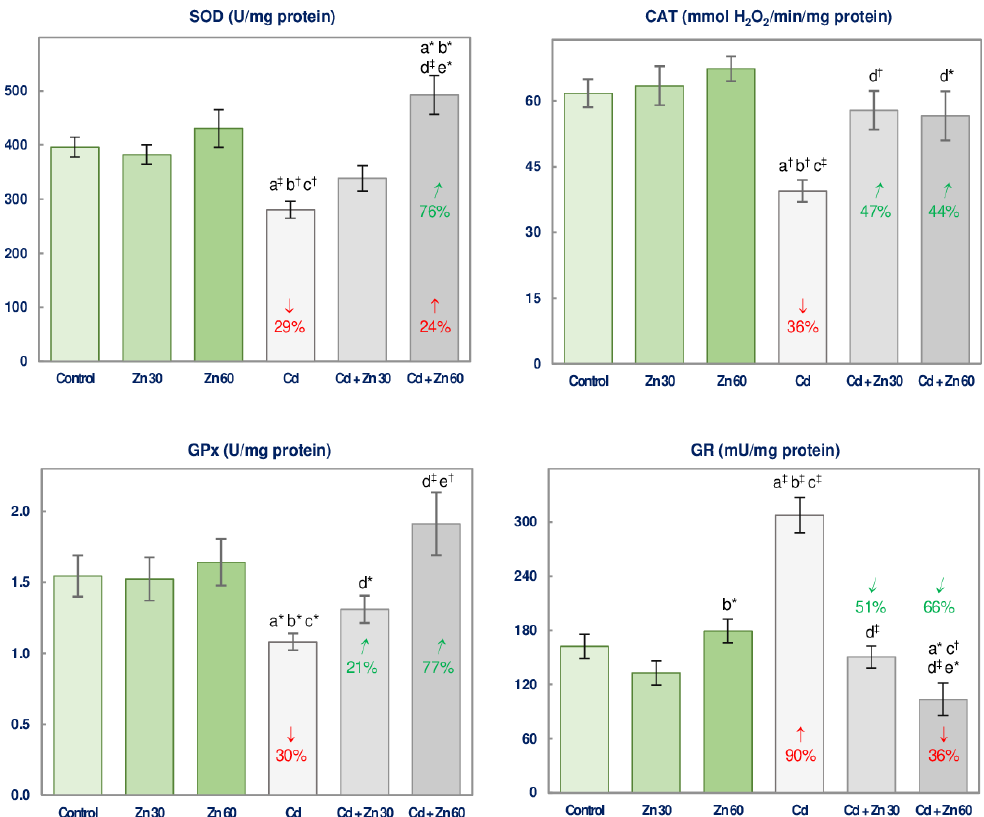
Figure 2. The activities of superoxide dismutase (SOD), glutathione peroxidase (GPx), glutathione reductase (GR), and catalase (CAT) in the brain tissue of male rats after 6-month treatment with cadmium (5 mg Cd/L) and/or zinc (30 or 60 mg Zn/L) via drinking water. Data are shown as mean ± standard error (SE) for 8 animals. Statistically significant differences: a vs. Control group; b vs. Zn 30 group; c vs. Zn 60 group; d vs. Cd group; e vs. Cd + Zn 30 group; * p < 0.05; † p < 0.01; ‡ p < 0.001. The values inside the bars (or above them) express the percentage changes vs. the control ( ↓ , decrease; ↑ , increase;) or Cd group ( ↙ , decrease; ↗ , increase). Table 2. Interactive and main effects of cadmium (Cd) and zinc (Zn) on the activities of superoxide dismutase (SOD),